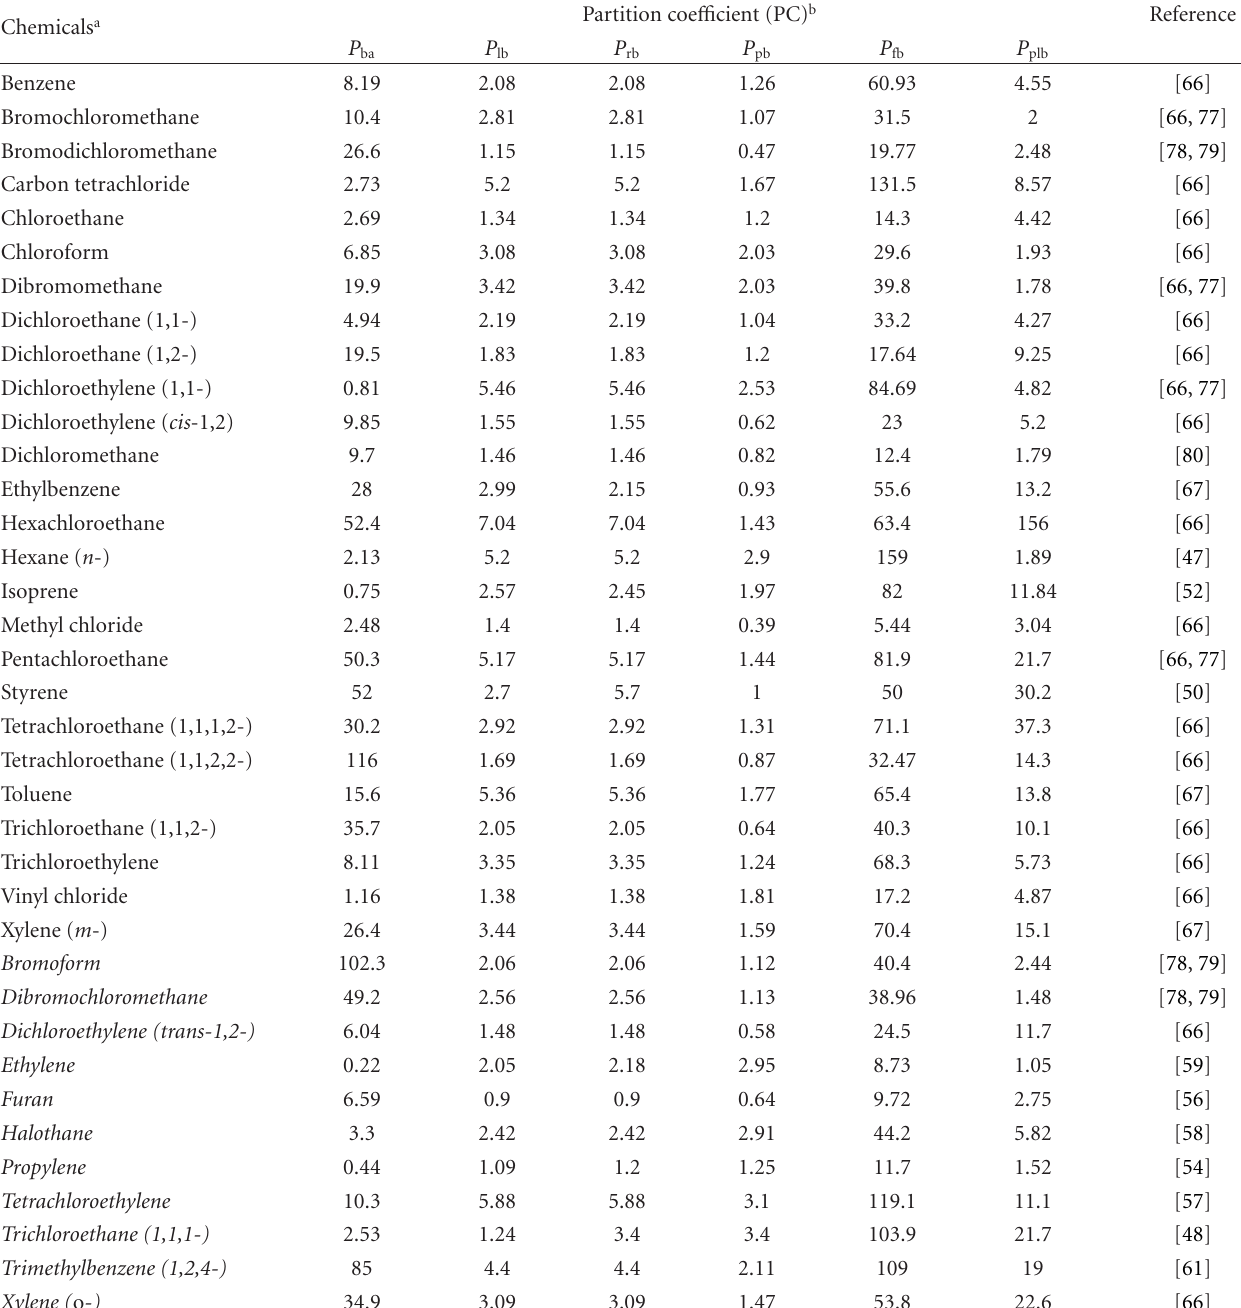
Table 1: Partition coe ffi cients used in the human PBPK